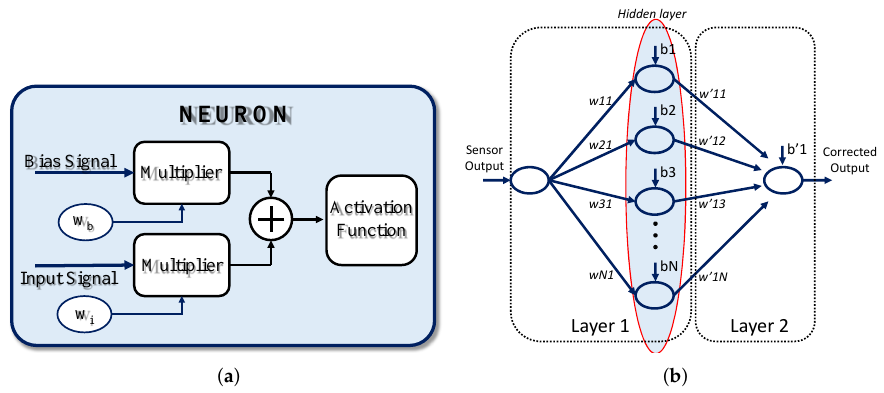
Figure 1. Artificial neural network (ANN) for sensor signal conditioning: ( a ) neuron block diagram, and ( b ) ANN